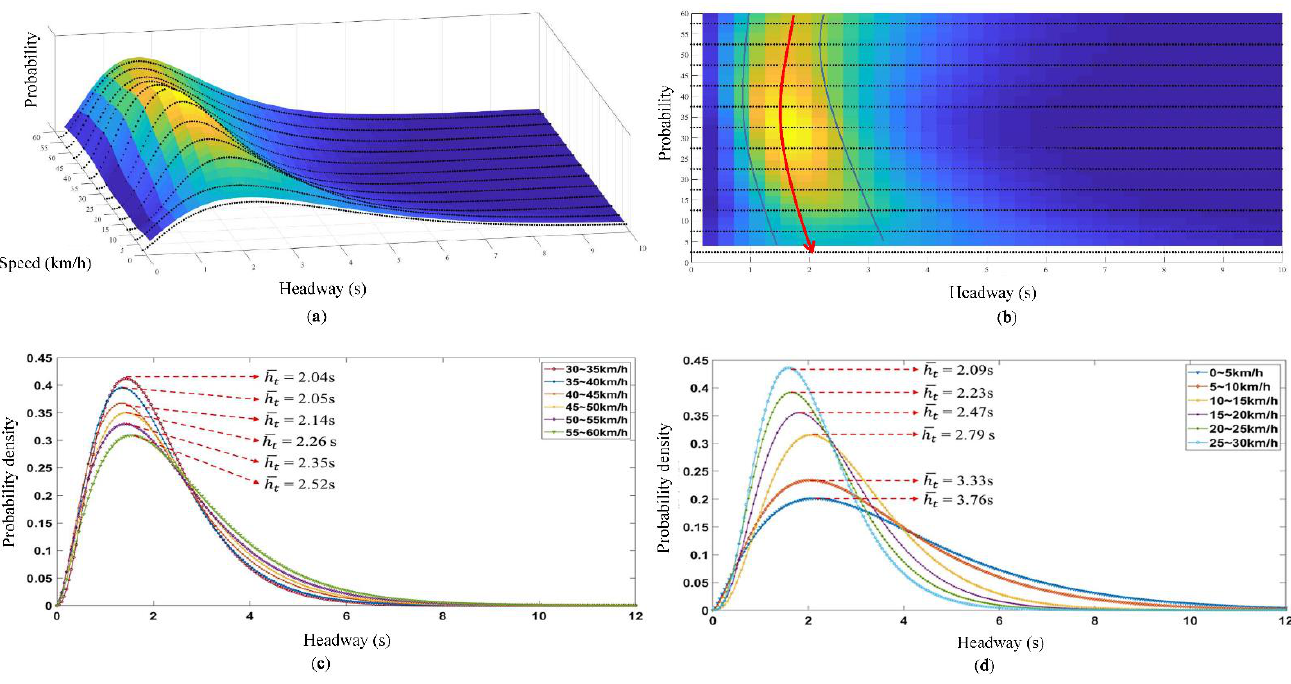
Figure 4. Probability distribution of headway. ( a ) Probability fitting diagram of speed-headway distribution in 3D, ( b ) Probability fitting diagram of speed-headway distribution in 2D, ( c ) Schematic diagram of the headway probability distribution fitting in the synchronous flow state, ( d ) Schematic diagram of the headway probability distribution fitting in the blocked flow state.